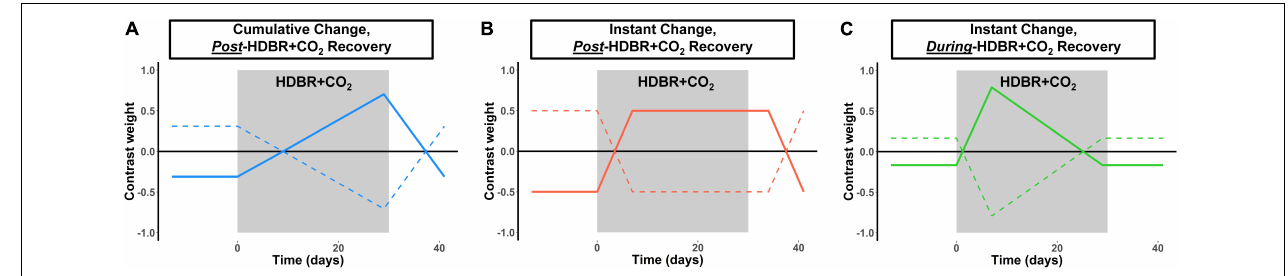
FIGURE 2 | Hypothesized changes in neural vestibular response to HDBR + CO 2 . We hypothesized three different longitudinal patterns of brain change: (A) Cumulative change, in which brain changes would slowly increase over the course of HDBR + CO 2 , followed by recovery after the conclusion of HDBR + CO 2 . (B) Instant change, in which brain changes would immediately onset after the start of HDBR + CO 2 , followed by recovery post-HDBR + CO 2 . (C) Instant change, in which brain changes would immediately onset the start of HDBR + CO 2 , but begin recovery during bed rest. We tested each of these hypotheses by using the contrast vectors shown here as weights in our longitudinal statistical model which assessed brain changes over all six time points for the HDBR + CO 2 group. Solid lines depict the positive version of each contrast; dotted lines depict the negative version of each